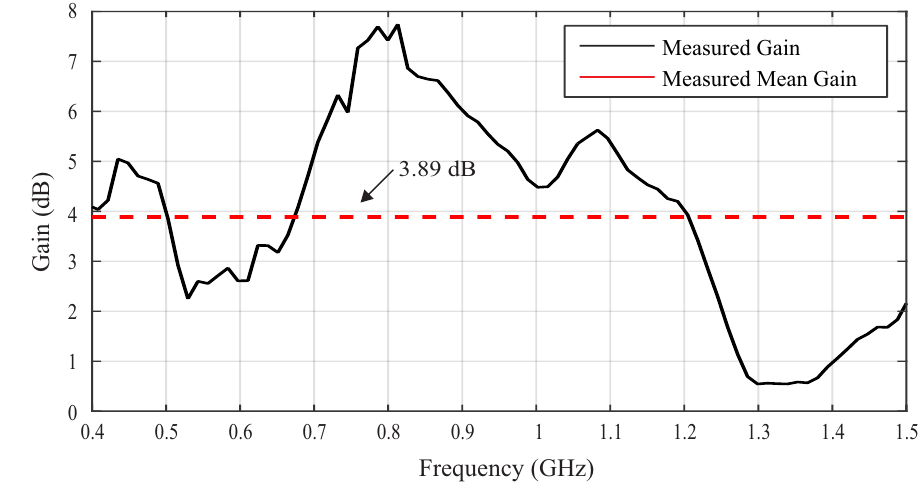
Figure 13. Measured UHF sensor